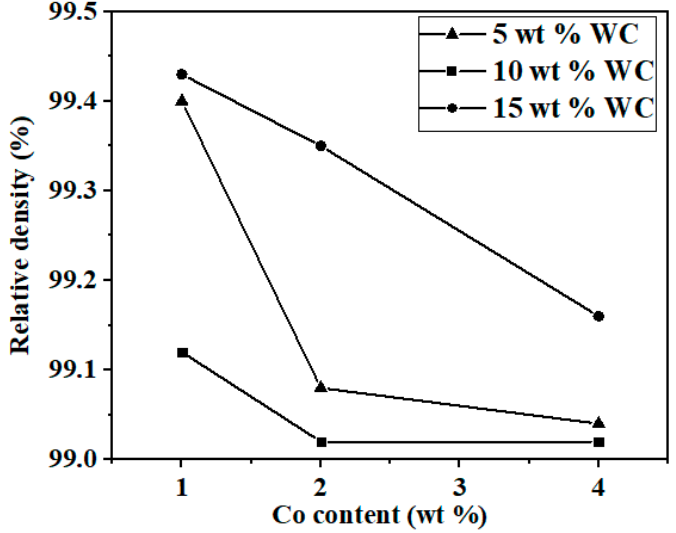
Figure 1. Relative density of the Si 3 N 4 /WC ceramic tool material at different WC and Co contents.